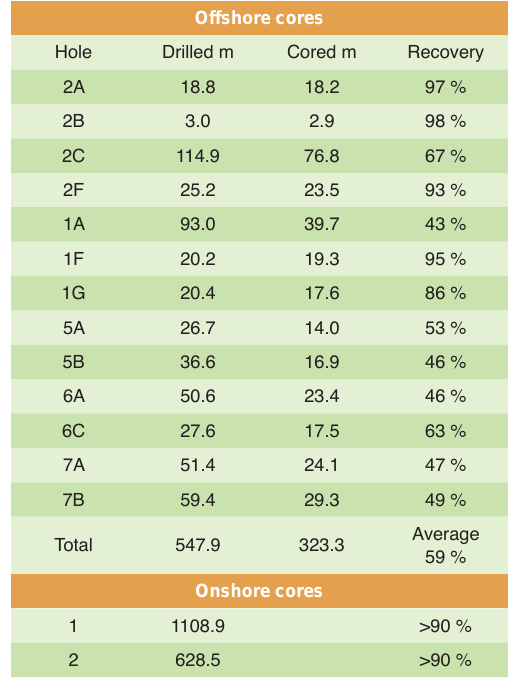
All other figures courtesy of the Lake Qinghai Drilling Project.